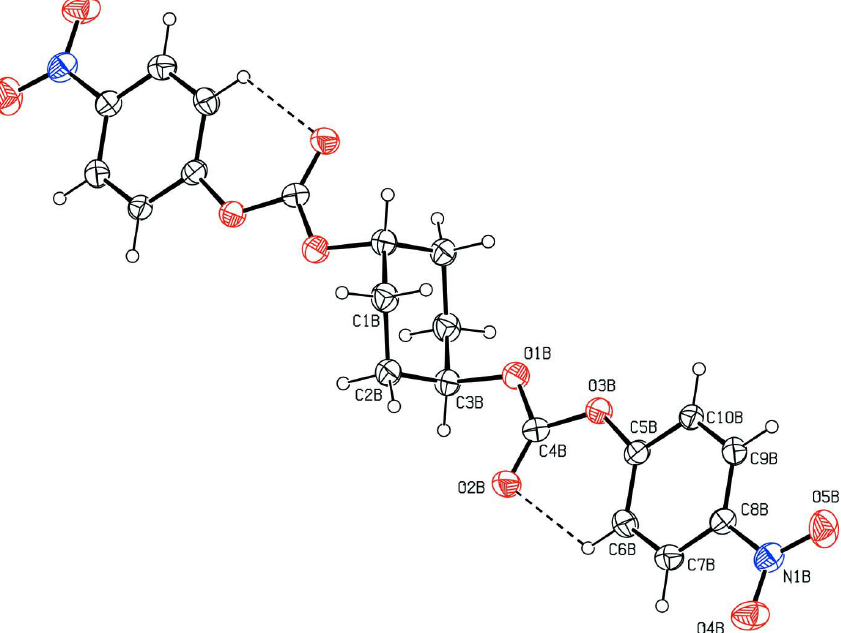
Figure 2 View of the other independent molecule of the title compound with displacement ellipsoids drawn at the 30% probability level. Unlabeled atoms are related by the symmetry operator (2 - x , 1 - y , - z ). The dashed line indicates a hydrogen